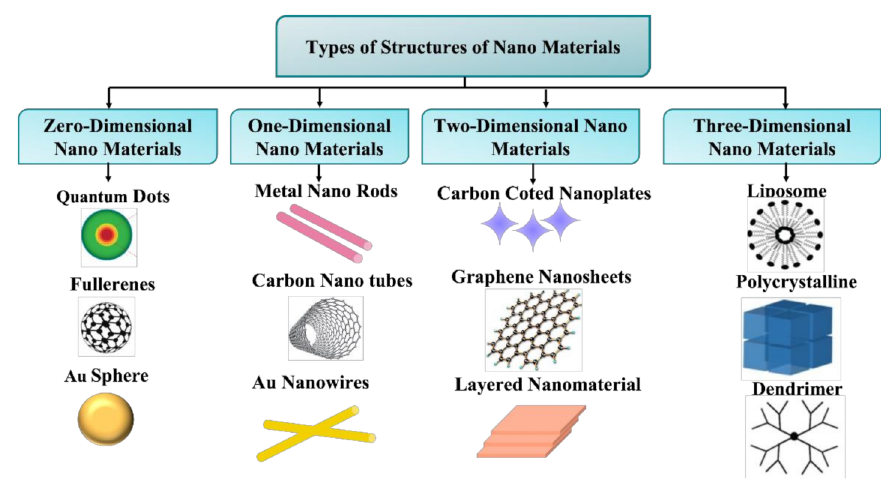
Figure 6. Classification of nanomaterials based on their dimensions, based on